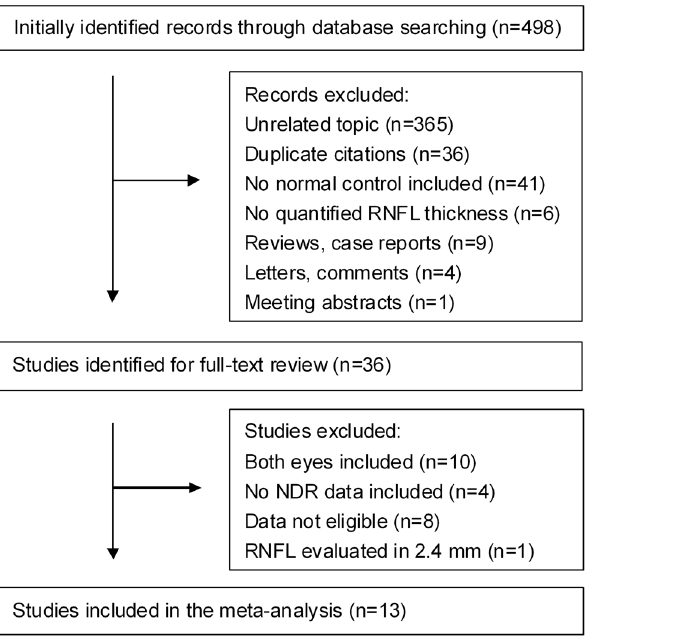
Fig 1. Process of study selection. NDR, diabetic patients without clinical diabetic retinopathy.